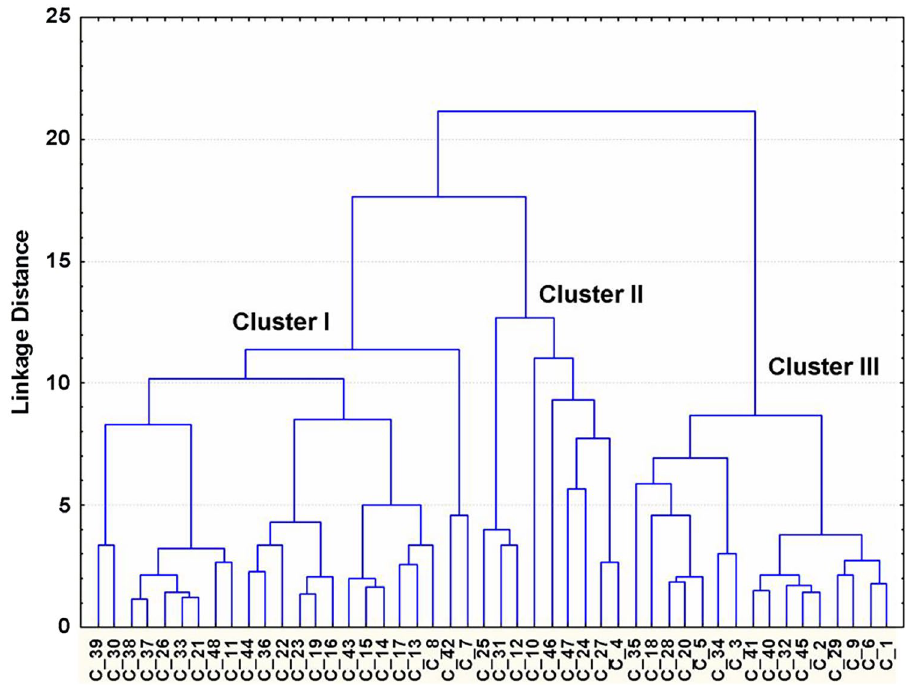
Figure 2. Graphical representation of the results of multi-dimensional cluster analysis of the data of cytokine production by IC-NST samples. The dendrogram is constructed by Ward’s method. In the dendrogram, the horizontal axis represents encrypted numbers of IC-NST samples from different patients, and the vertical axis indicates the union distance (Euclidean distances). Clusters I, II and III are formed from relatively similar indicators of different cytokine production (pg/ml) by IC-NST samples and correspond to different profiles of cytokine production by IC-NST samples from different patients.